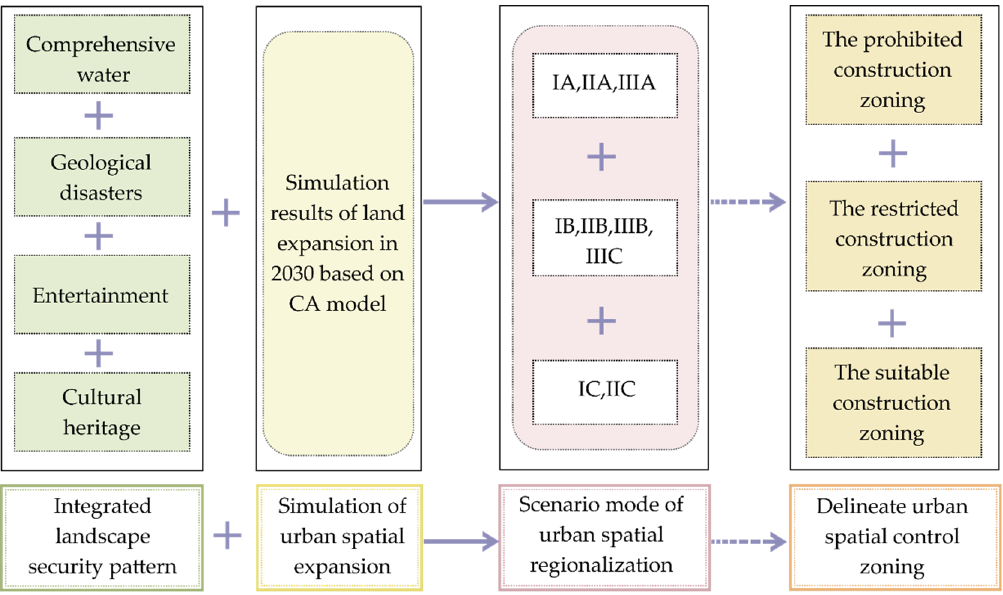
Figure 3. Division process of urban spatial control zoning.